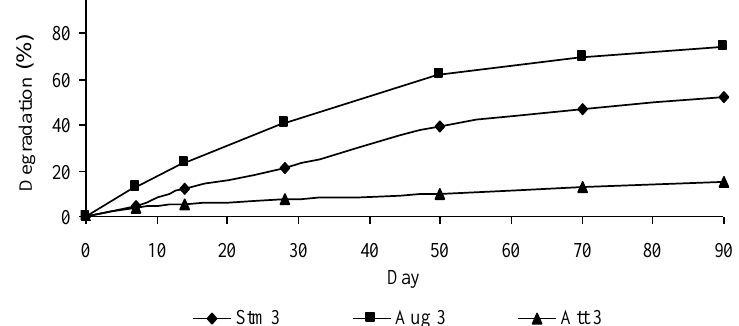
Figure 1. Comparison natural attenuation, biostimulation and bioaugmentation in 3 g oil concentration Almost half of the oil in bioaugmentation reactors was utilized in the first month in 3 g oil concentration. Degradation was fast in first month and after day 50 it was significantly slower, it clearly means that in present of acclimatized microorganism as well as nitrogen and phosphorus, a satisfactory amount of biodegradation is reachable in about two months and more time does not efficient compared to first 50